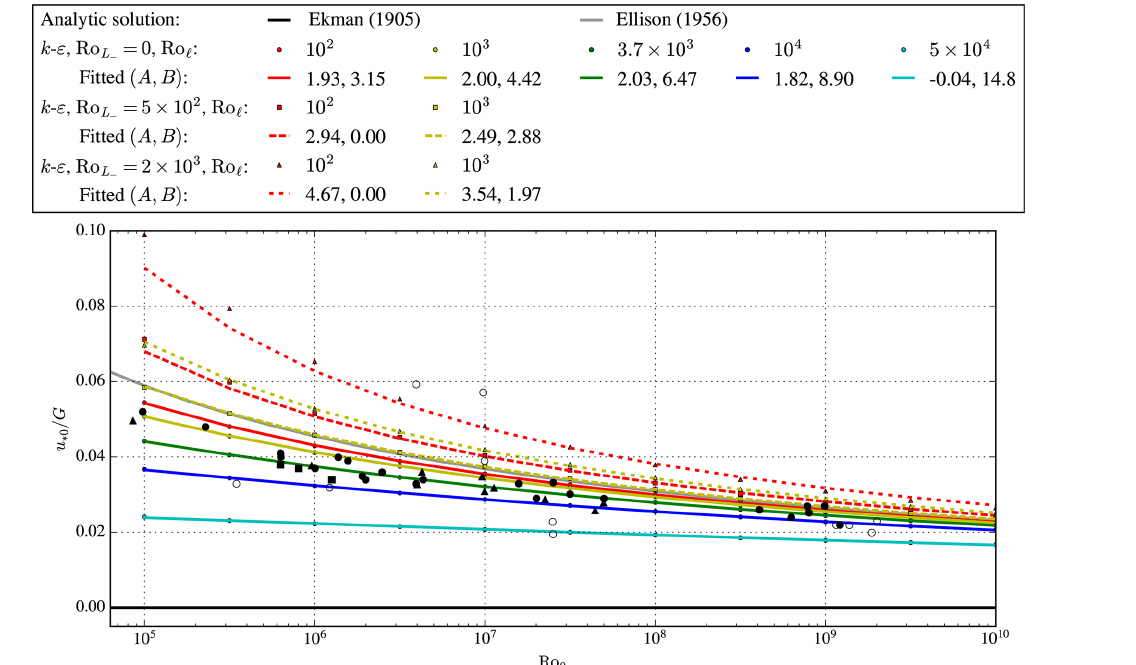
Figure 6. Reproduced from Hess and Garratt (2002). Geostrophic drag coefficient simulated by the limited-length-scale k – ε model extended to unstable surface layer stratification, taken at a normalized height of ( z + z 0 ) | f c | /G = 5 × 10 − 5 (i.e., in the surface layer), for different Ro 0 , Ro (cid:96) , and Ro L . Black markers represent measurements from Hess and Garratt (2002). Ro (cid:96) = 3 . 7 × 10 3 represents (cid:96) max from Blackadar − (1962). Analytic results of Ekman (1905) and Ellison (1956) are summarized in Appendix